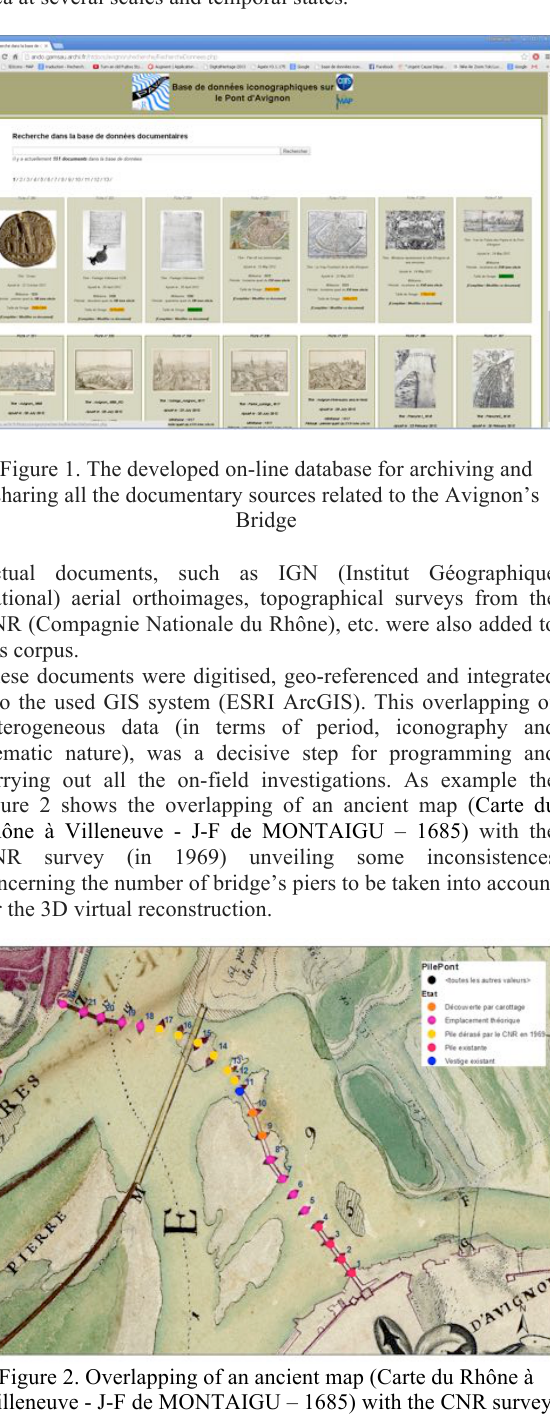
Figure 4. Orthoimage of east façade of Saint-Bénézet Church, generated with Apero/MicMac starting from images acquired from a